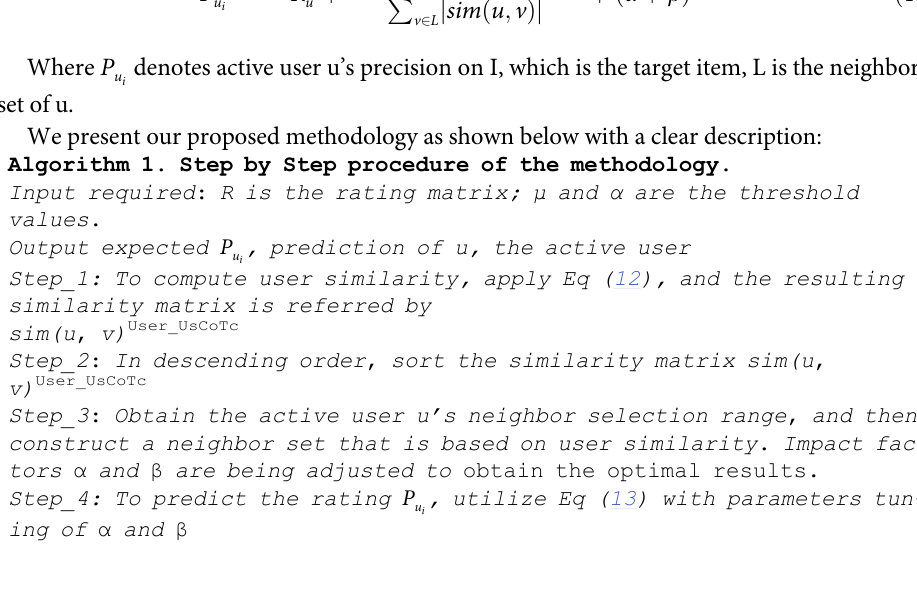
Algorithm 1. Step by Step procedure of the methodology